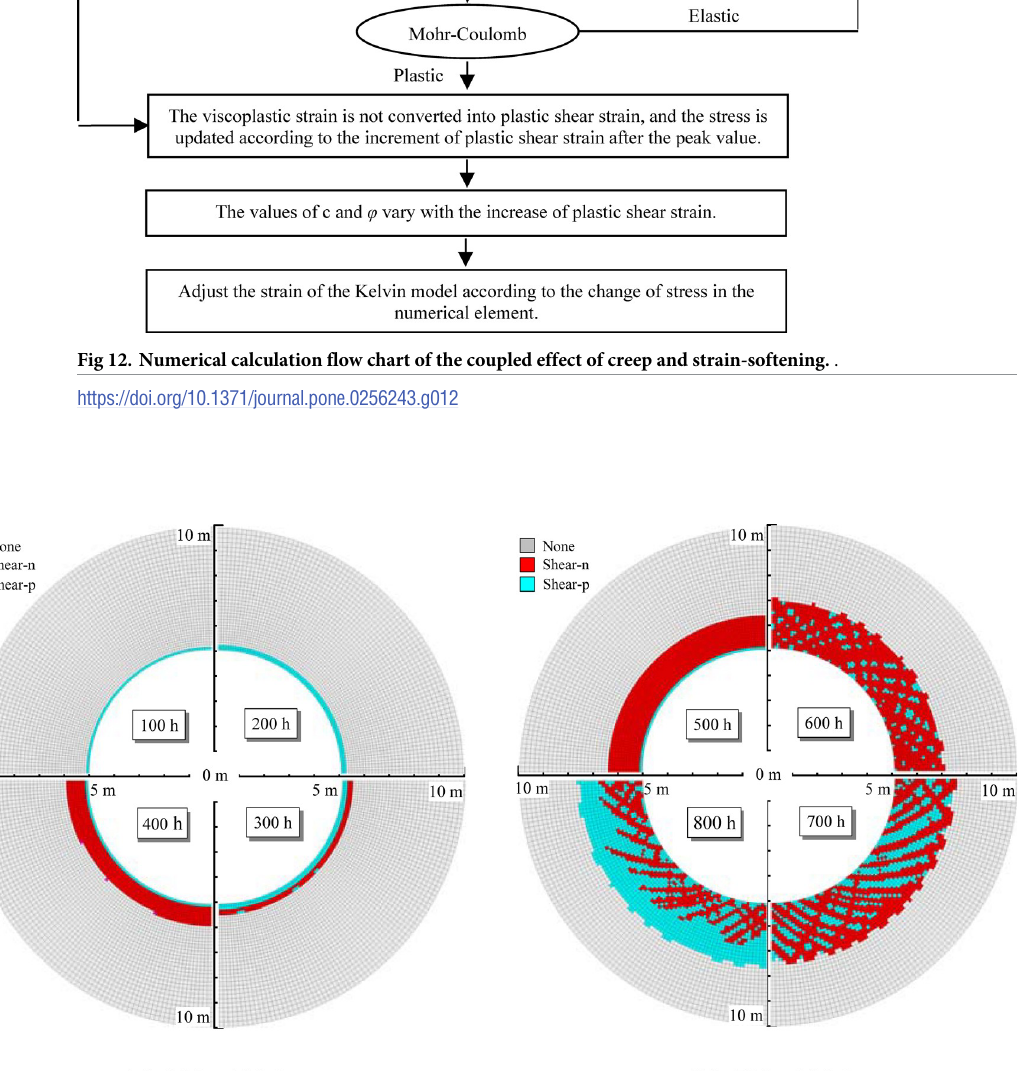
PLOS ONE | https://doi.org/10.1371/journal.pone.0256243 August 26,